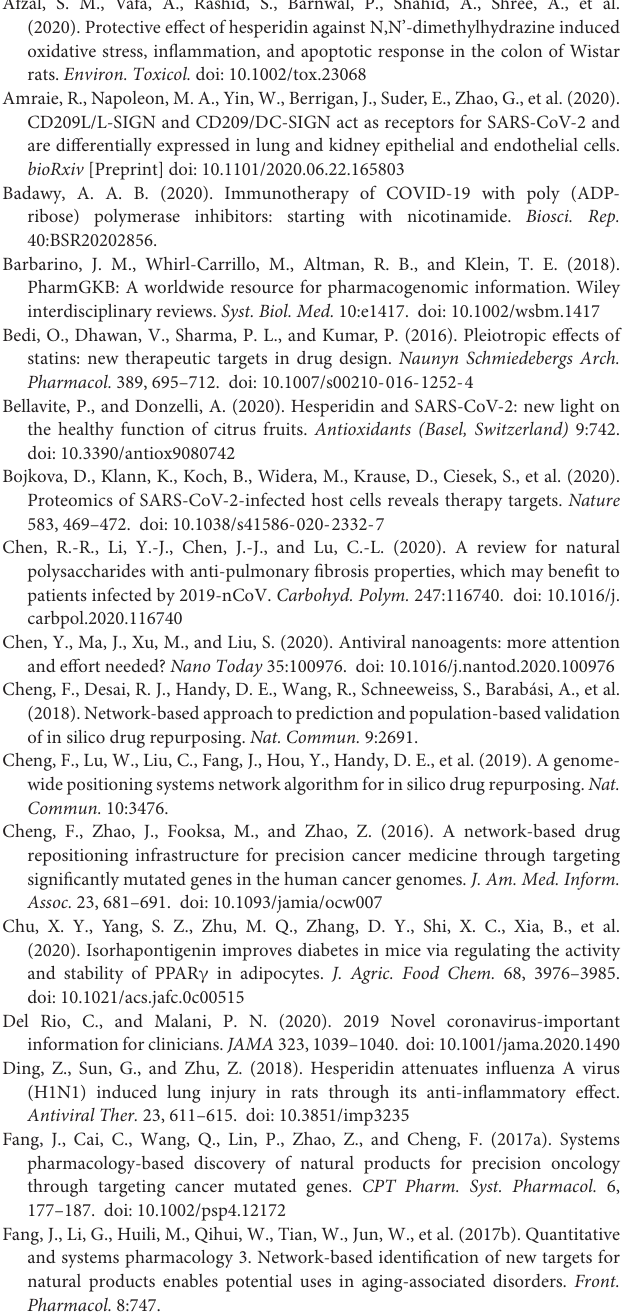
Supplementary Table 1 | Detailed information of three sets of host proteins obtained from latest public literature.